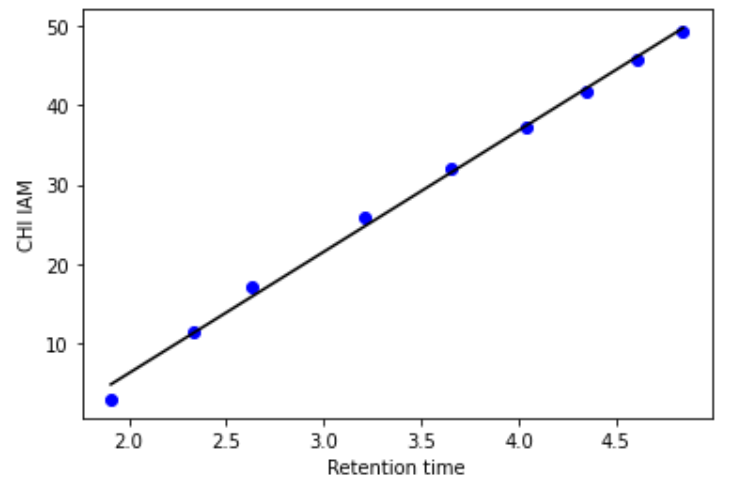
Figure 2. Calibration cure of the IAM-HPLC: acetaminophen (t R 1.93, CHI IAM 2.90), acetanilidine (t R 2.37, CHI IAM 11.50), acetable (t R 2.66, CHI IAM 17.20), propiohenone (t R 3.22, CHI IAM 25.90), butyrophe- none (t R 3.67, CHI IAM 32.00), valerophenone (t R 4.04, CHI IAM 37.30), hexanophenone (t R 4.35, CHI IAM